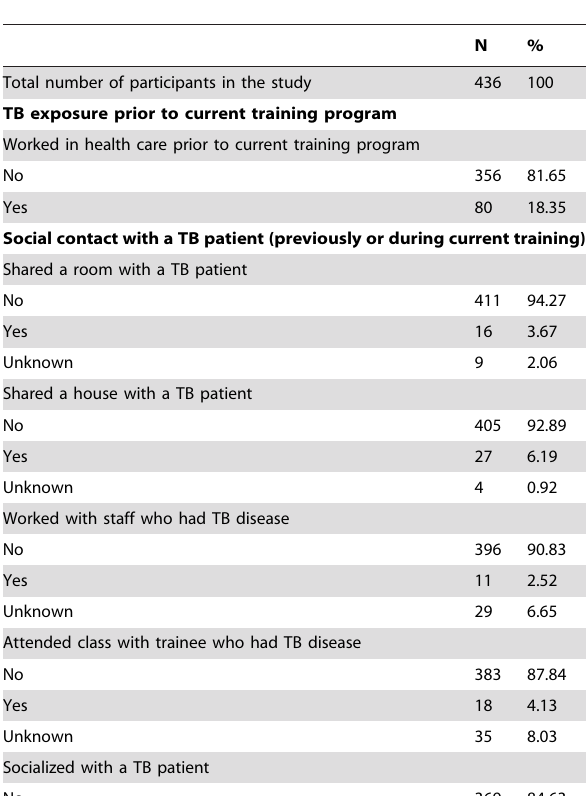
Table 2. Clinical characteristics of the participants